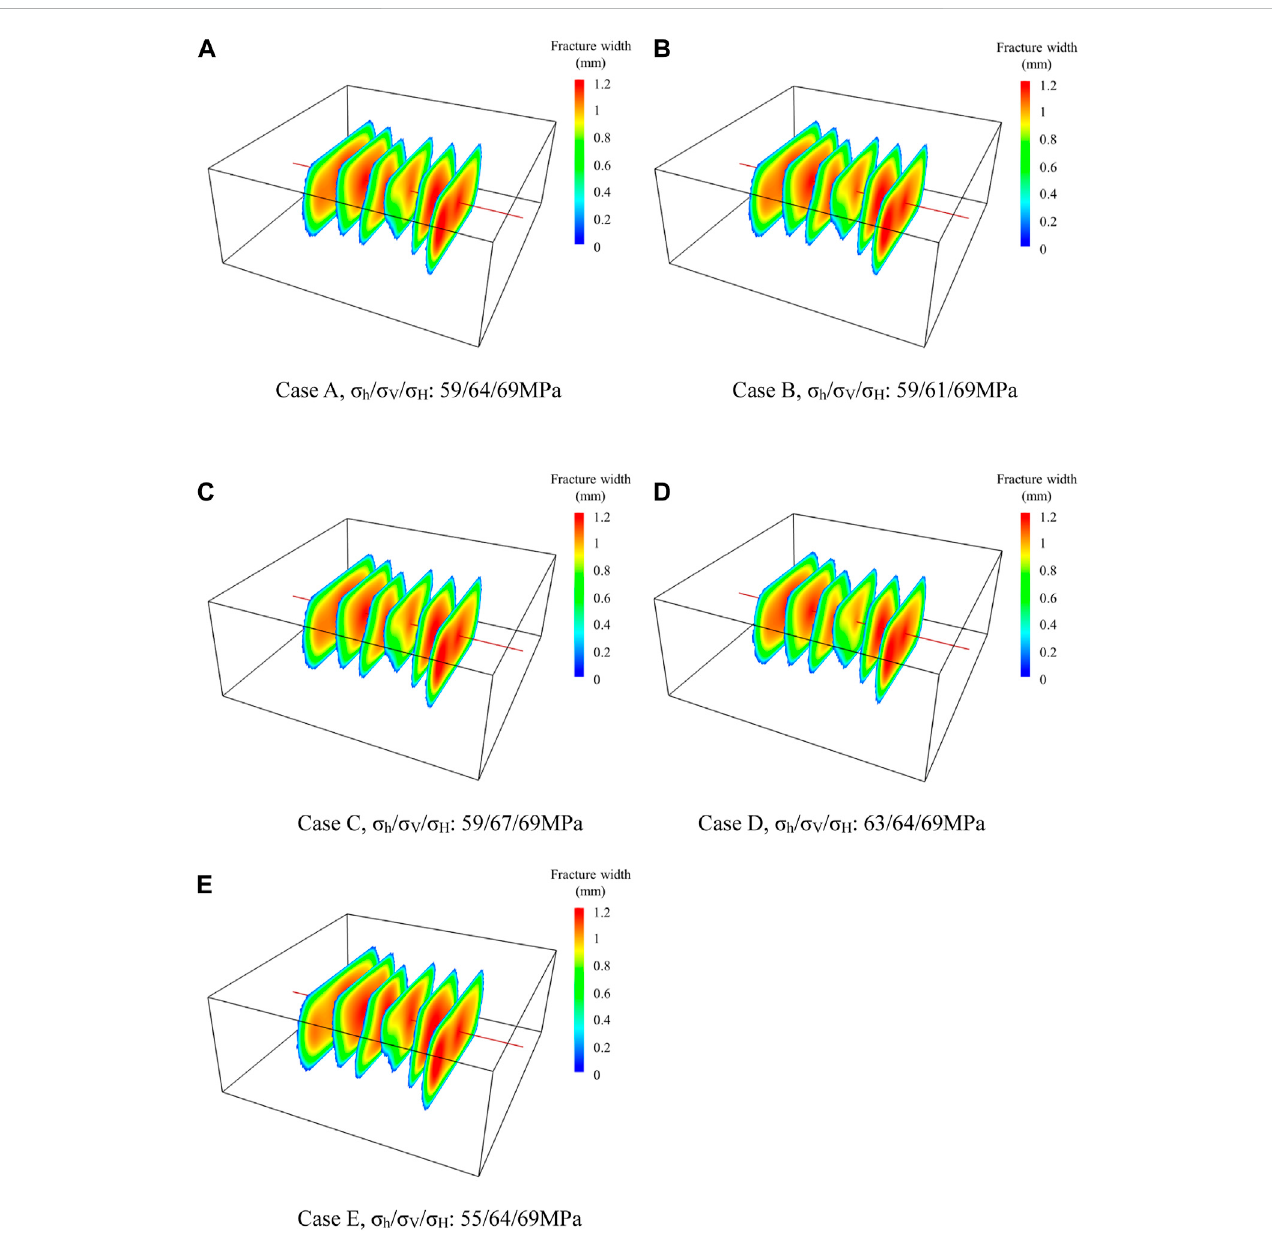
FIGURE 3 Fracture morphology for fi ve cases with different in-situ stress combination states. (A) Case A, σ h / σ V / σ H : 59/64/69 MPa. (B) Case B, σ h / σ V / σ H : 59/61/ 69 MPa. (C) Case C,